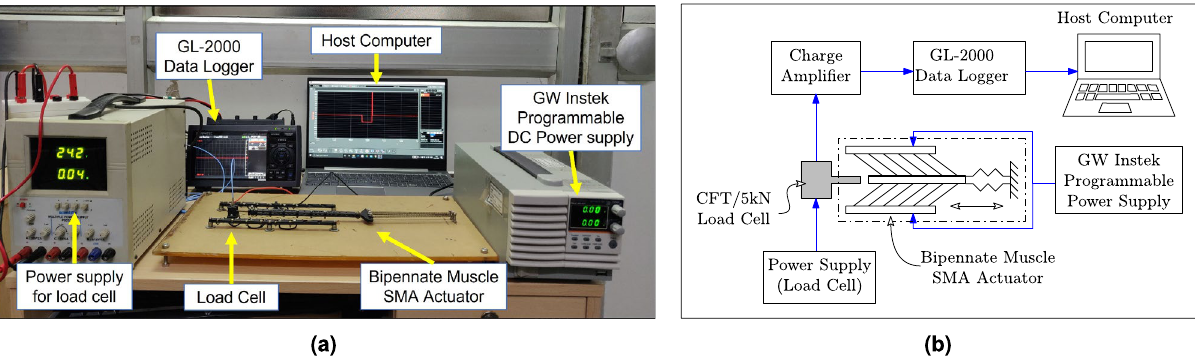
Figure 10. ( a ) The SMA-based linear actuation system was set up in an experiment to measure the force generated by the actuator. A load cell measures the block force and is powered by a 24V constant power supply. A 7 V voltage difference is applied throughout the full length of the cable using a GW Instek programmable DC power source. The SMA wire contracts as a result of the heating, and the movable arm comes in contact with the load cell exerting blocked force. The load cell is connected to the GL-2000 data logger, and the data is saved on the host computer for post processing. ( b ) A schematic showing the circuit of the components of the muscle force measurement experimental setup. PACEline CFT/5kN load